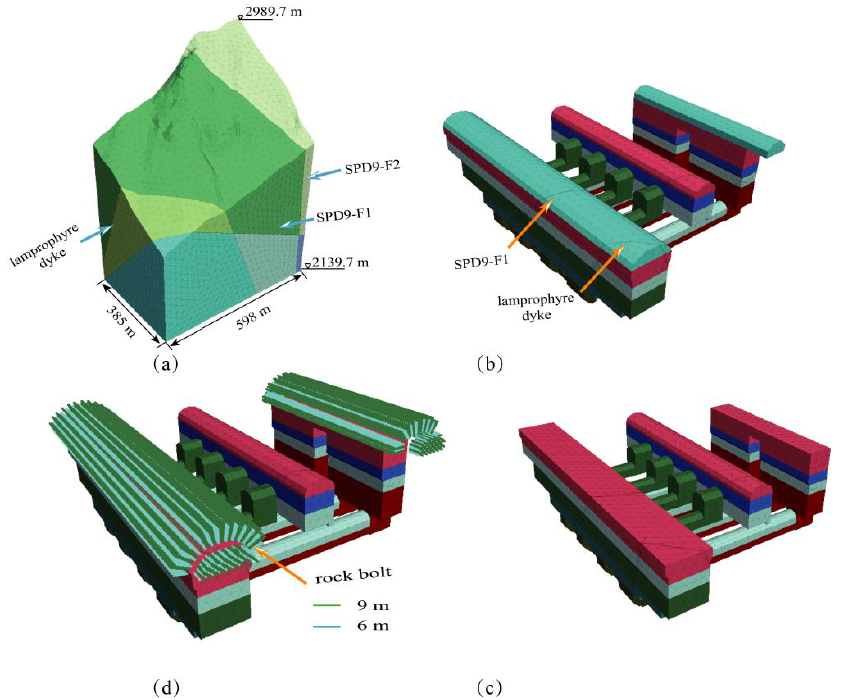
Figure 11. Three-dimensional numerical model: ( a ) 3D numerical model; ( b ) numerical model of three major caverns; ( c ) completion of bench I; ( d ) schematic diagram of the support. Table 3. Mechanical parameters of the rock mass.